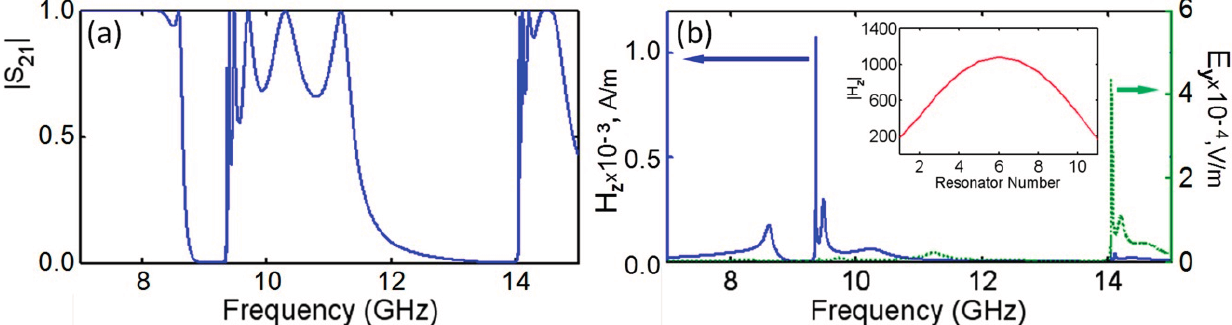
Figure 6. ( a ) Transmission spectra of finite DR array showing fringes near the edges of the 2nd and 3rd transmission bands; ( b ) signal spectra of H- and E-field